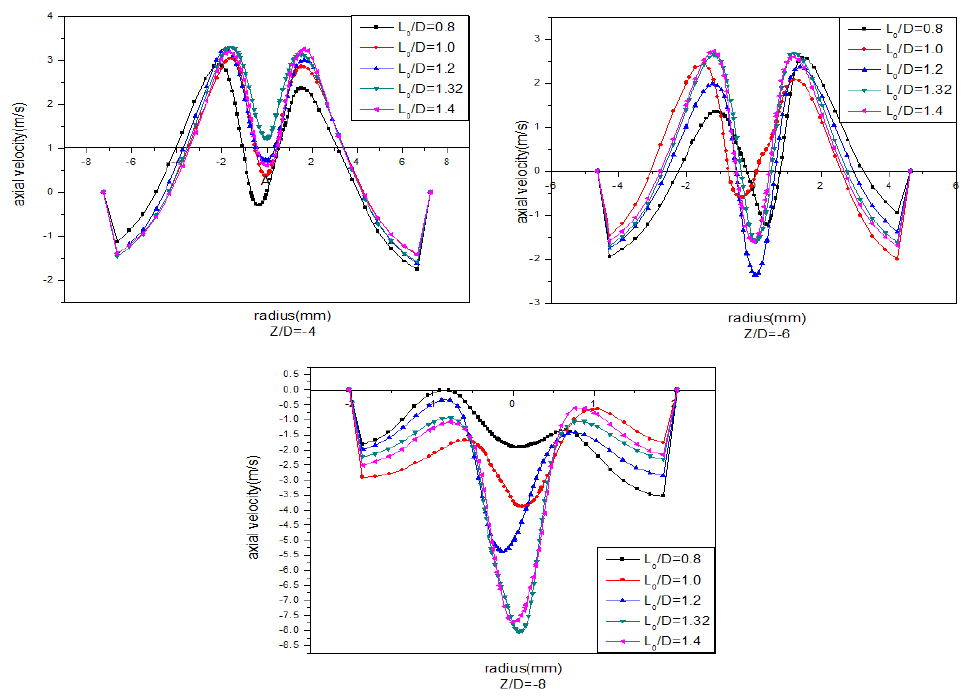
Figure 7. Comparative analysis chart of the axial velocity of mini-hydrocycloness.